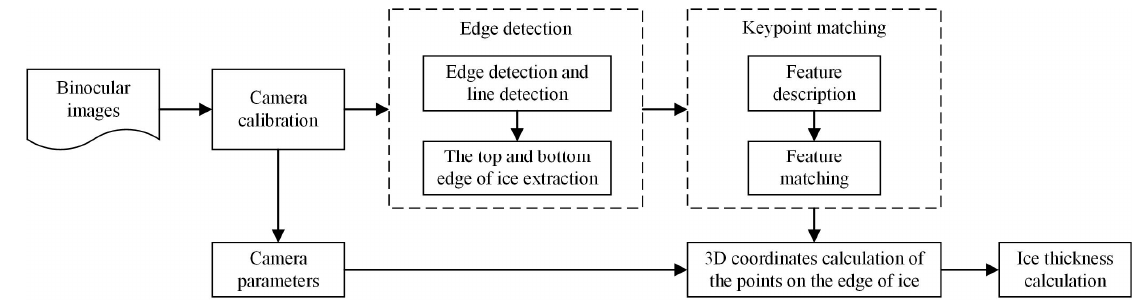
Figure 4. The flowchart of ice thickness measurement.